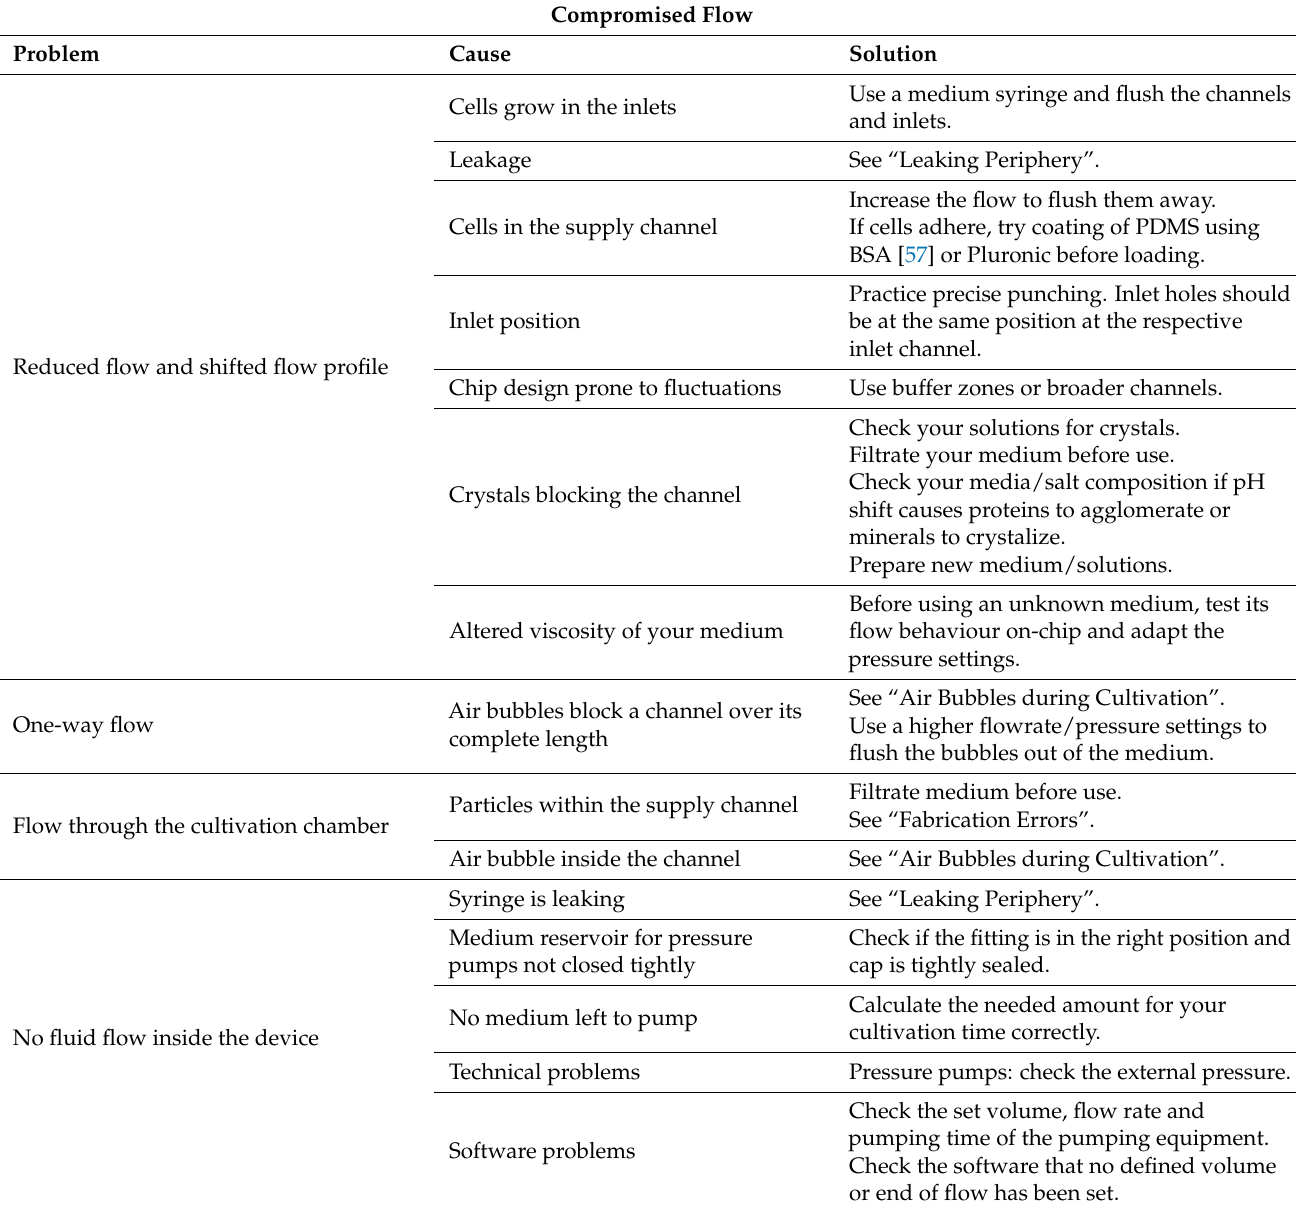
Table 6. Listed are the most frequently occurring challenges concerning compromised flow with their respective cause and a suggested